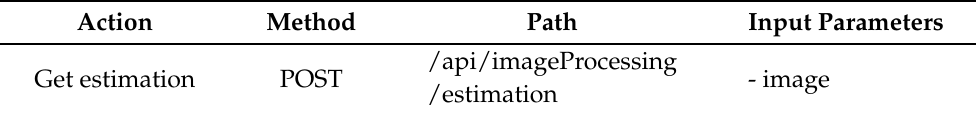
Table 4. REST API for the Machine Learning